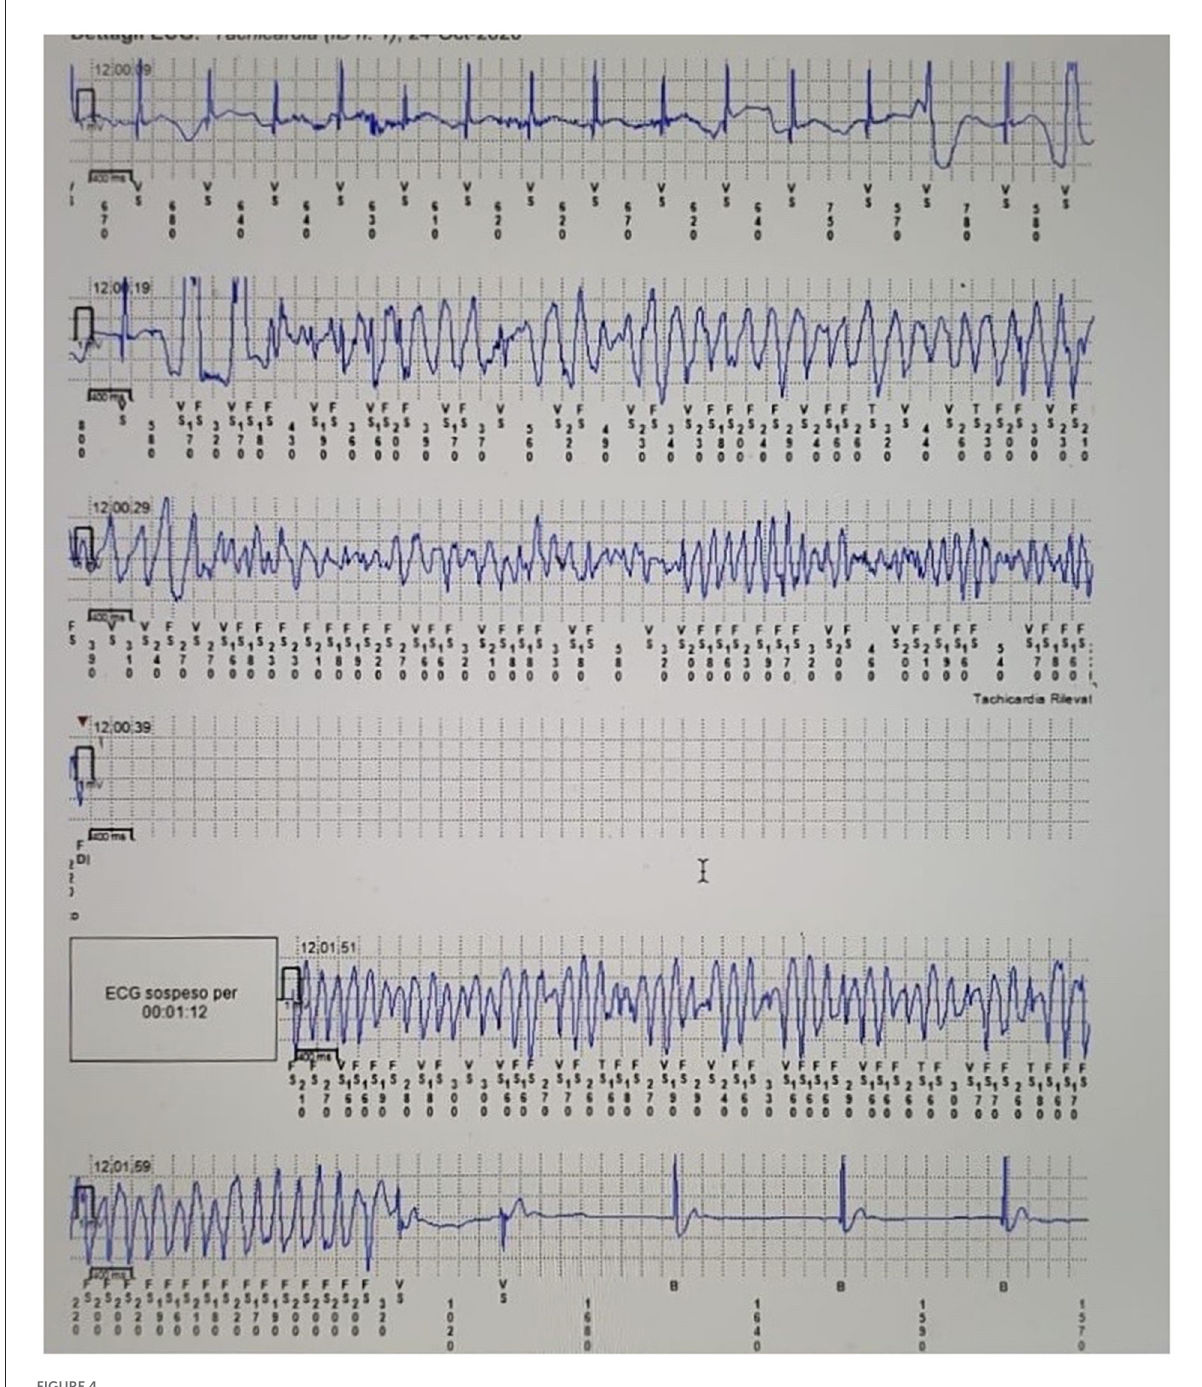
FIGURE4 Proband’s loop Recorder trace during cardiac arrest, showing QTc prolongation, ectopic ventricular beats and ventricular